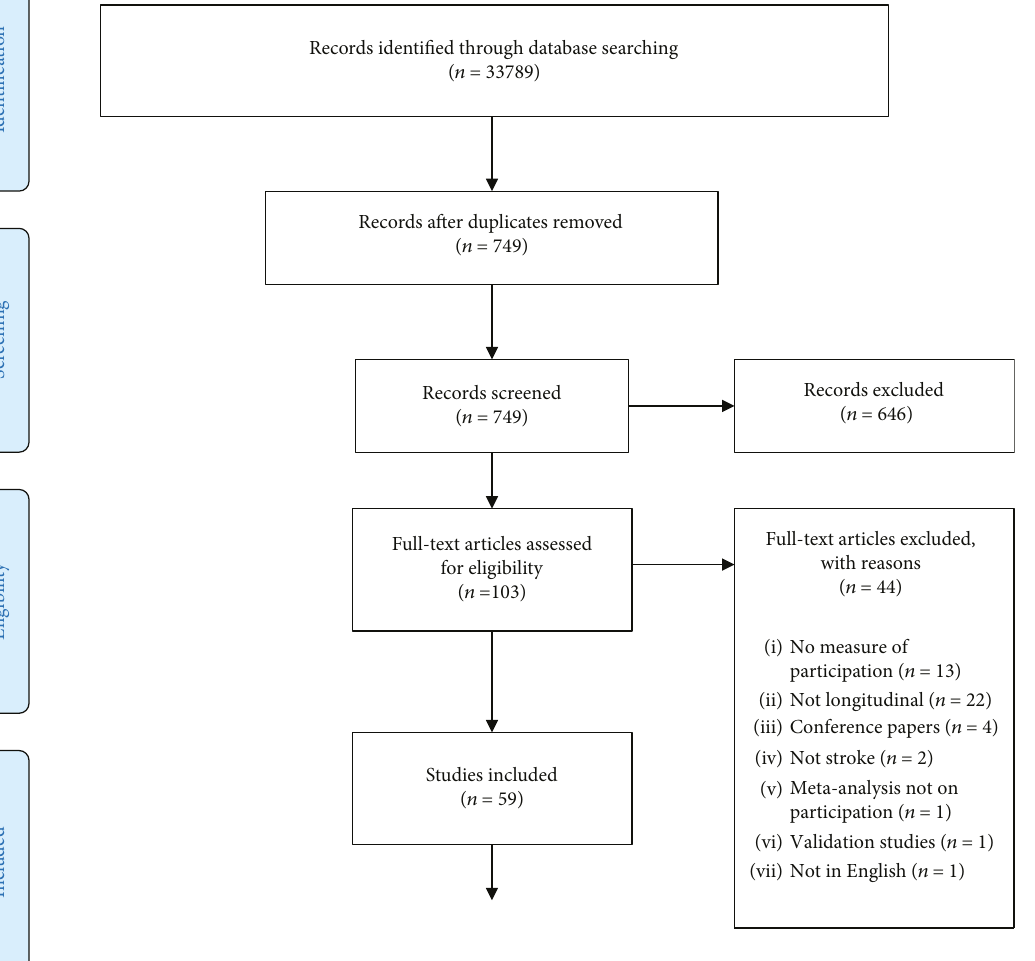
Figure 1: PRISMA 2009 fl ow